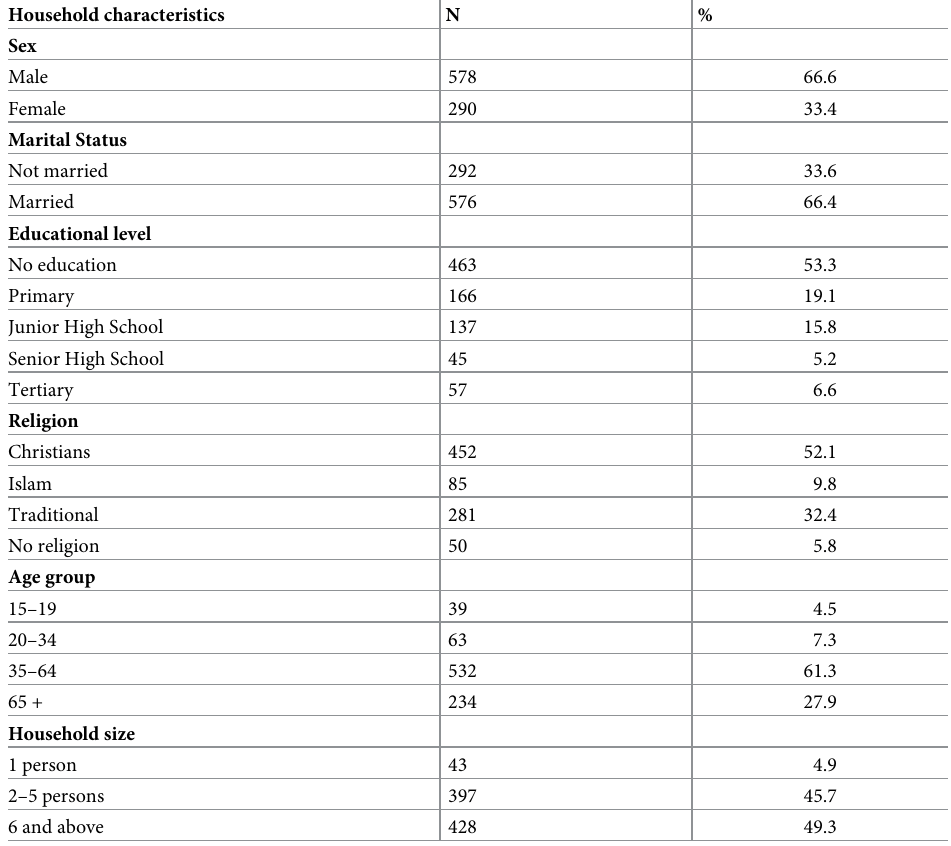
Table 2. Demographic characteristics of household